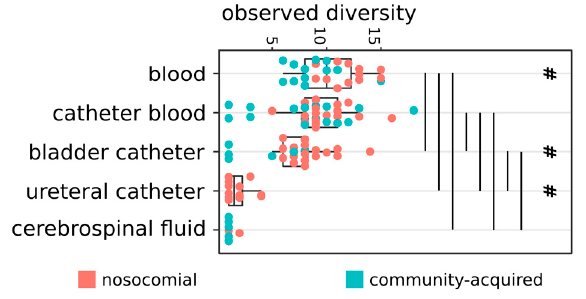
Figure 2. Number of species per group of isolates. Strains isolated at the same time (month and year) from the same type of specimen and recognized as having the same origin (nosocomial or community-acquired) were considered as belonging to the same group. Vertical lines show significant differences among the connected groups of strains (Wilcoxon fdr < 0.05); # = significant differences between the number of species in nosocomial and not-nosocomial groups from the corresponding specimen (Wilcoxon fdr < 0.05).